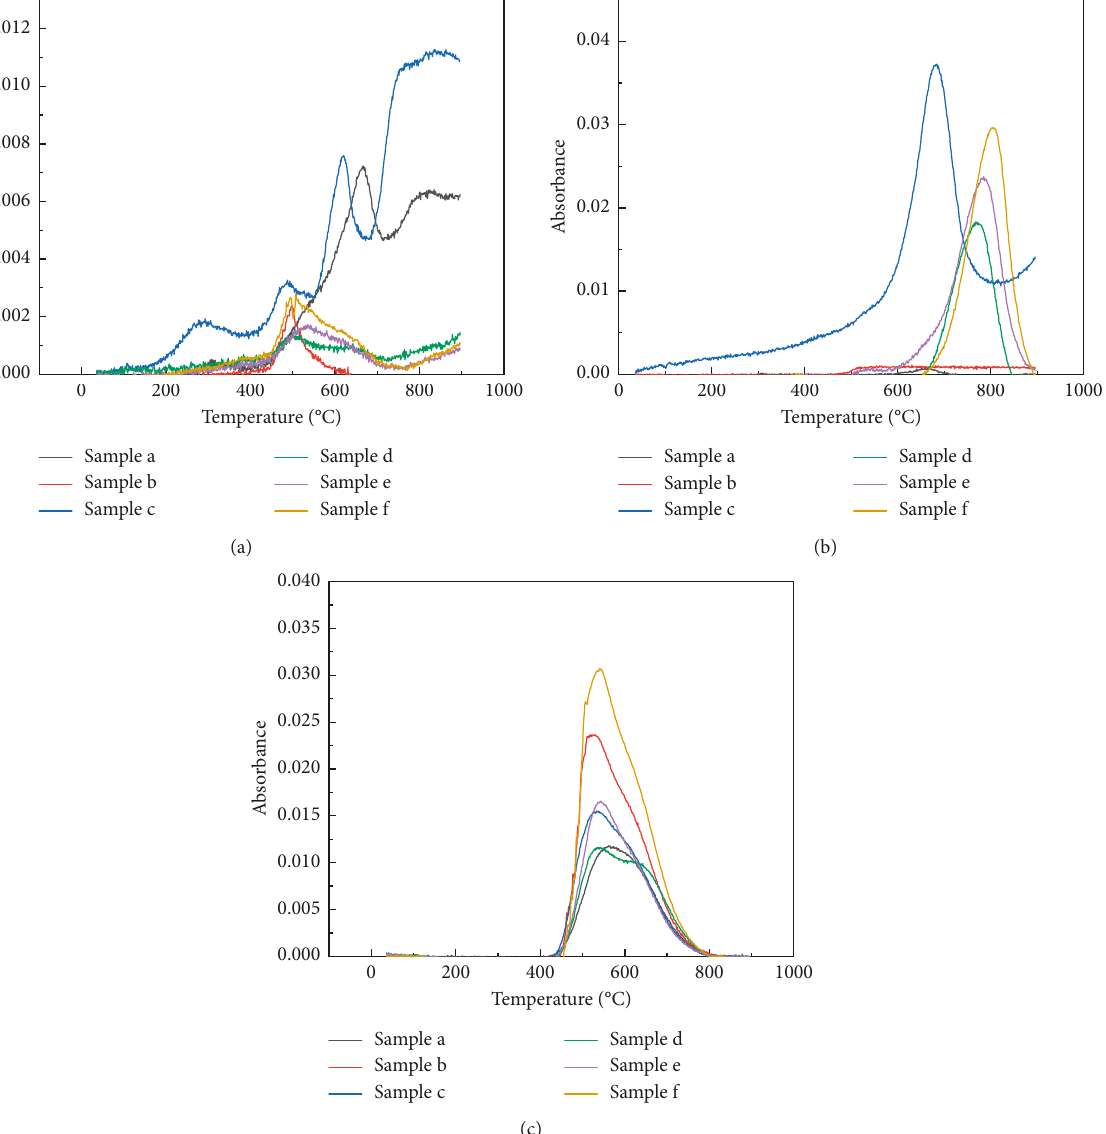
Figure 6: The infrared absorption rate-temperature diagram for three wave